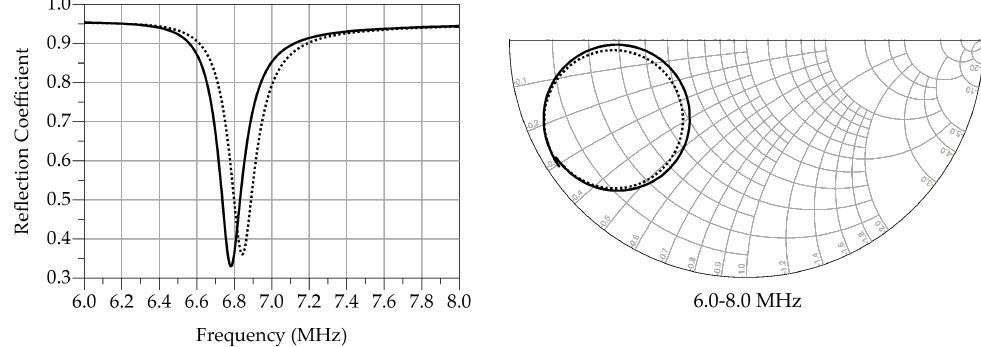
Figure 8. One-port antenna measurements in the presence (dashed) and absence (solid) of the Wheeler Cap: ( Left ) magnitude response, ( Right ) complex input